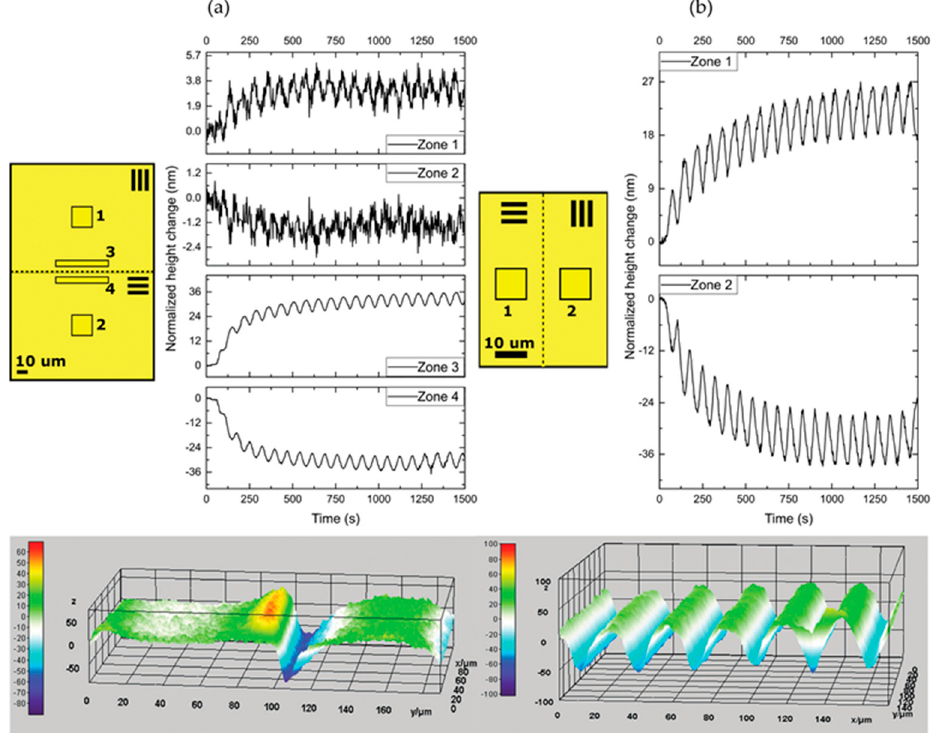
Figure 12. Oscillations and topographies observed in azo-LCN coatings aligned in orthogonal domains with sizes of 100 µm ( a ) and 20 µm ( b ) upon polarized light actuation. Topographies and their oscillations are located on and around the defect line. Reproduced from [106].